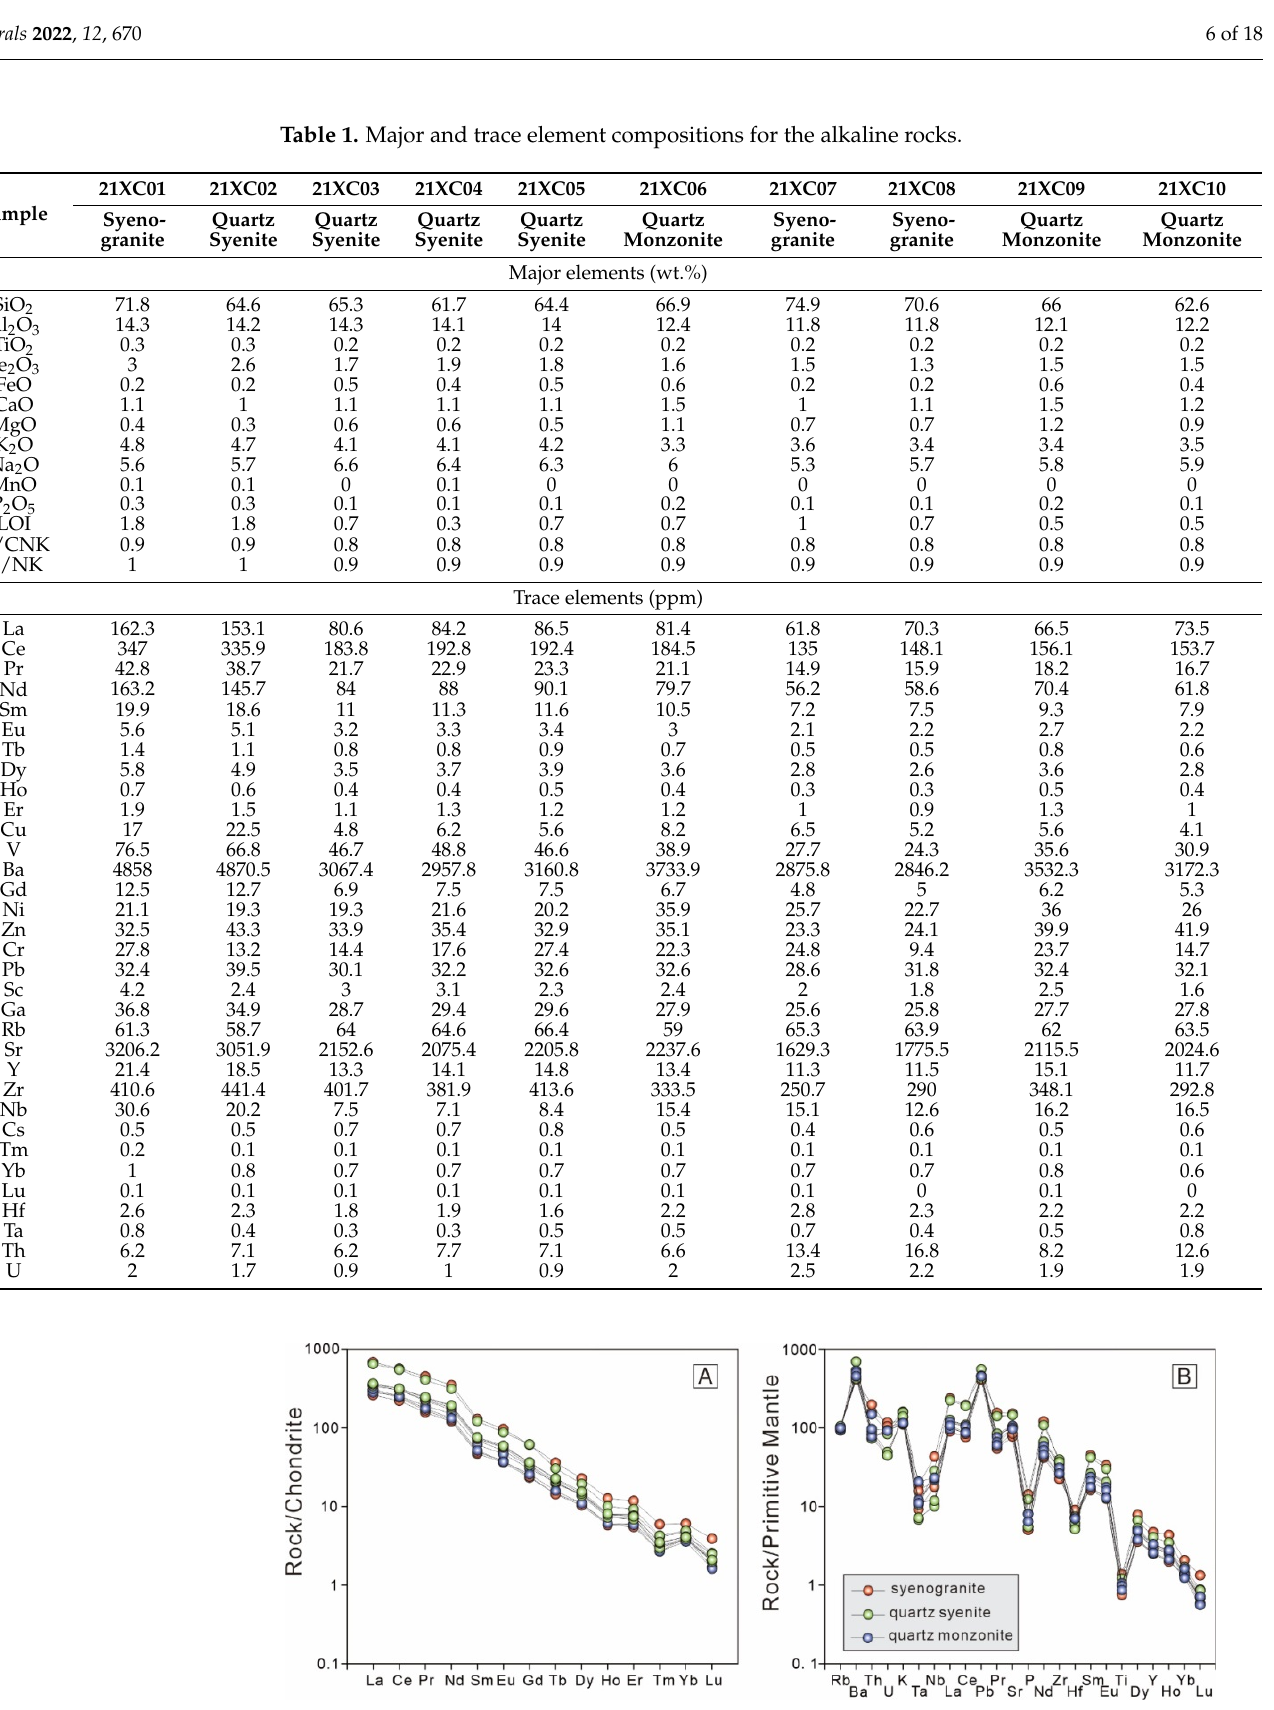
Figure 5. ( A ) Chondrite-normalized REE patterns [36]; ( B ) Primitive mantle-normalized trace element patterns [37].